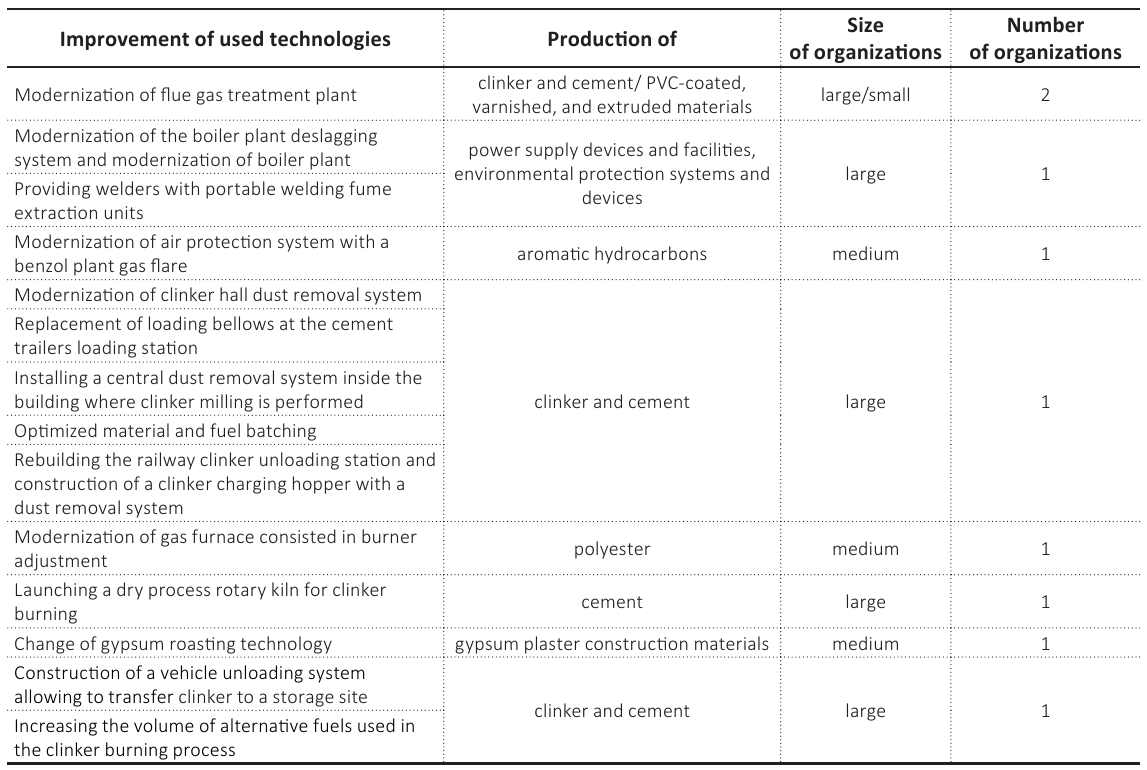
Table 3. Solutions implemented by Polish companies registered with EMAS to improve technologies to reduce